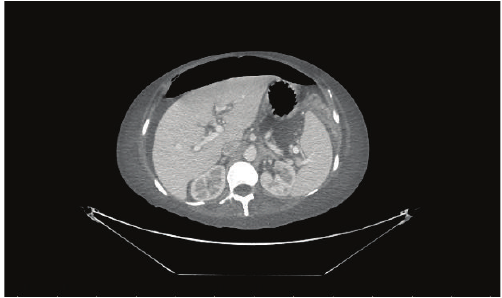
Figure 3: CT scan showing fibrosis of